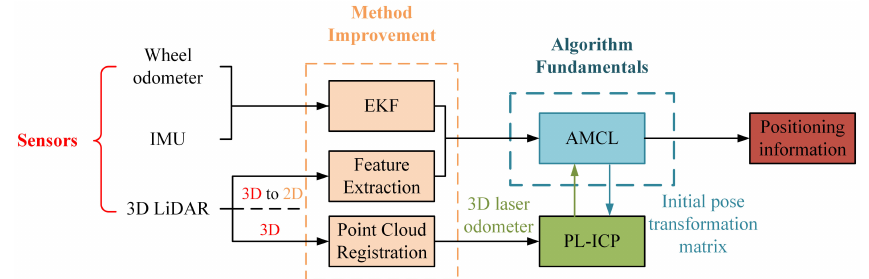
Figure 1. Framework of improved AMCL localization algorithm based on